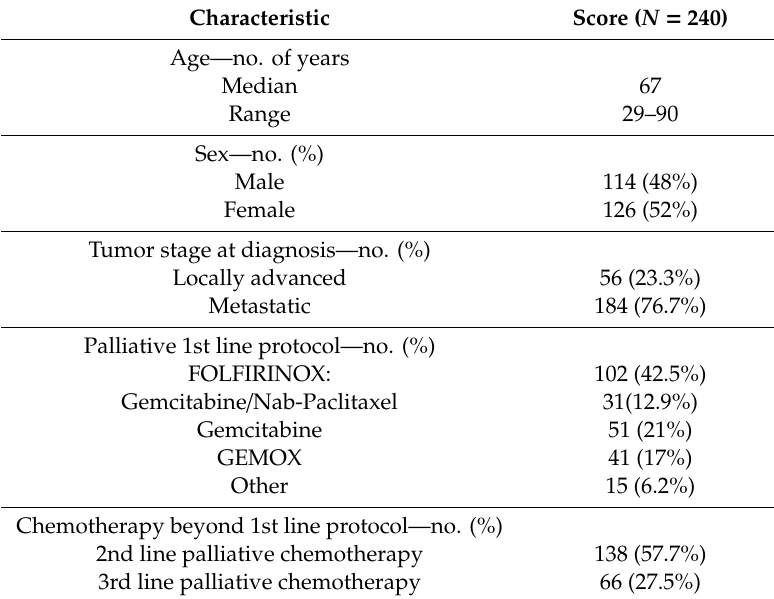
Table 1. Characteristics of the Salzburg Pancreas cohort 240 patients